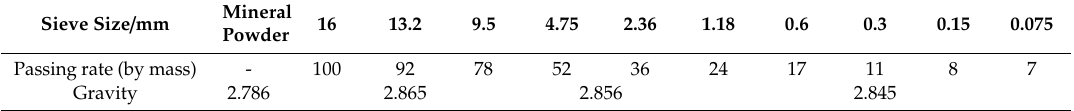
Table 3. Gradation of the asphalt mixture and gravity of aggregates of di ff erent particle sizes.